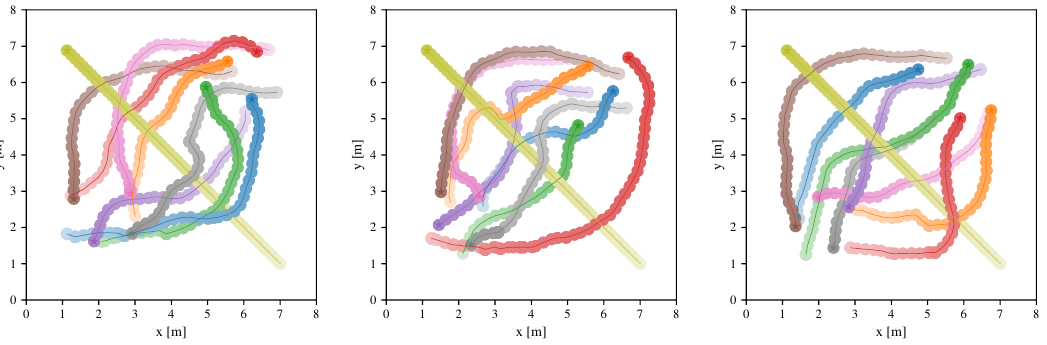
Figure 5. The scenario with non-cooperative robots, where eight robots are controlled by the learned policy to interact with a non-cooperative robot. The non-cooperative robot (with the yellow color) moves along a straight line at a speed of 0.5 m/s, robots represented by other colors are controlled by the same learned collision avoidance